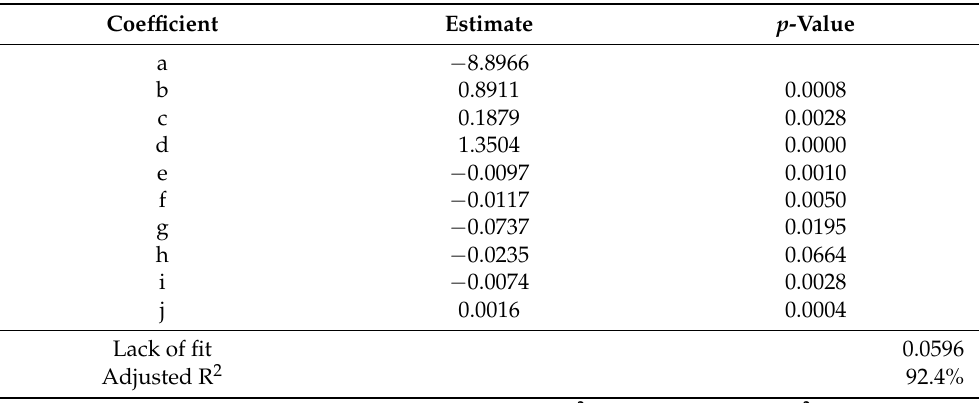
Table 2. Regression coefficients for the induction time (t i ) .